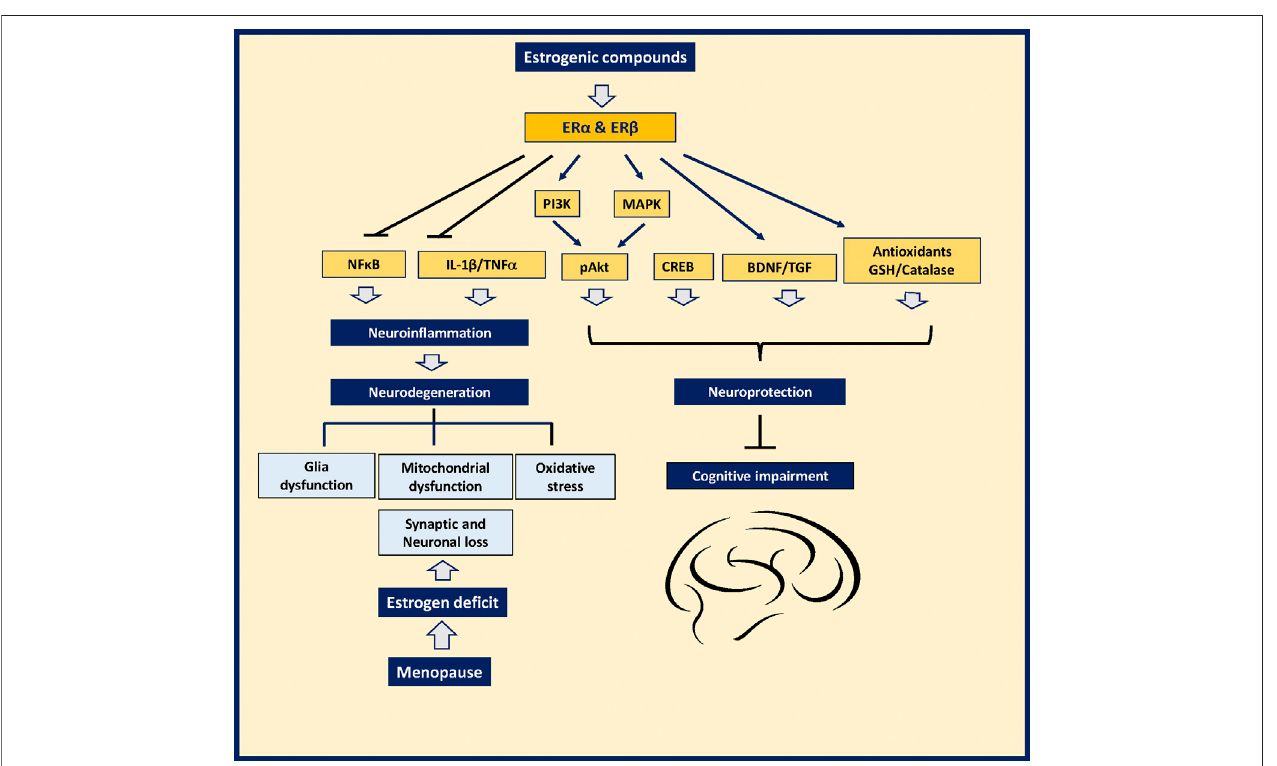
FIGURE 1 | Mechanism of action of estrogenic plants to prevent neurodegeneration and memory loss and other symptoms in women after menopause.